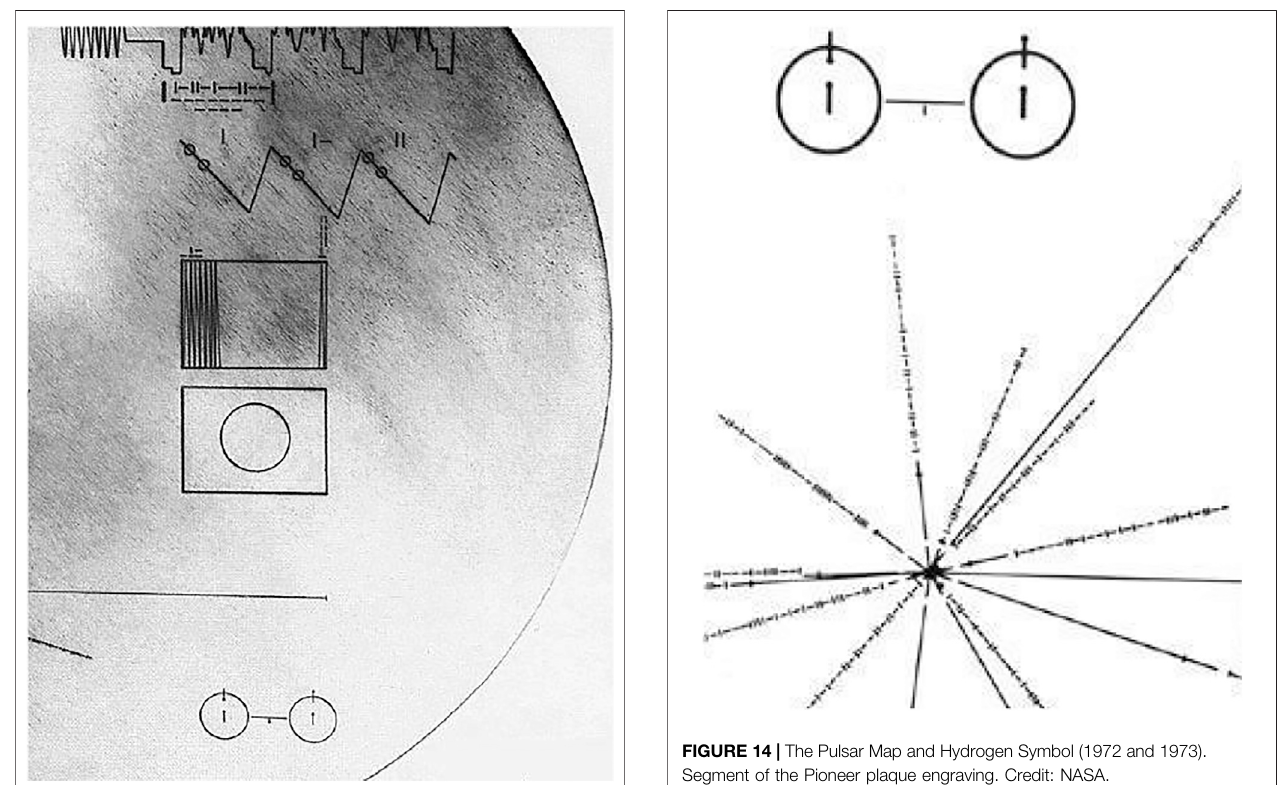
Frontiers in Human Dynamics |